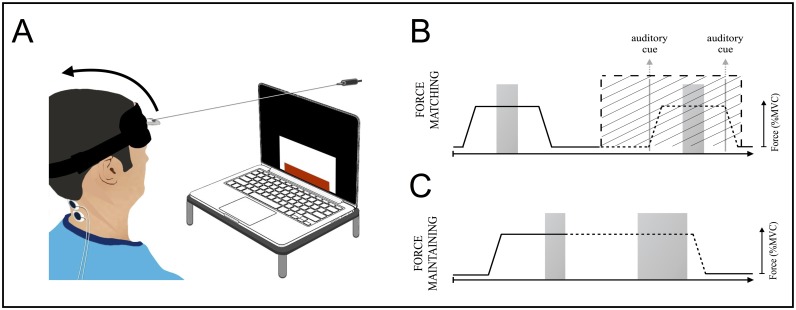
Setup and visuomotor tasks.(A) Setup for visuomotor tasks. Subjects were seated in front of a computer screen. A headband was attached to the force sensor by a non-extensible wire. The task consisted of a series (trials) of visually displayed target forces (height of white rectangle) to be matched as closely as possible using visual feedback of the exerted neck force (height of red rectangle). (B) Force matching task: subjects matched the neck extension force to an indicated target level (5% or 20% MVC) with visual force feedback (condition_Vis) and reproduced the same force level without visual feedback (condition_NoVis). In conditions without vision, subjects were given an auditory cue indicating force onset, offset or hold. Five trials/condition were presented in a pseudo-randomized order. Force exerted during the stable part of the hold phase, indicated by grey shading, was analyzed. (C) Force-maintaining task: subjects maintained their extension force at target level with visual feedback (condition_Vis). The visual feedback was then removed for six seconds (condition_NoVis) and vibration was applied (condition_NoVis+Vib).